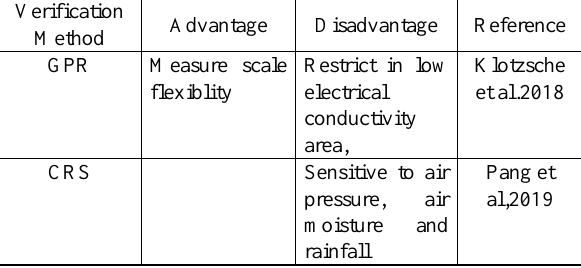
Table 2 Comparison of region scale verification